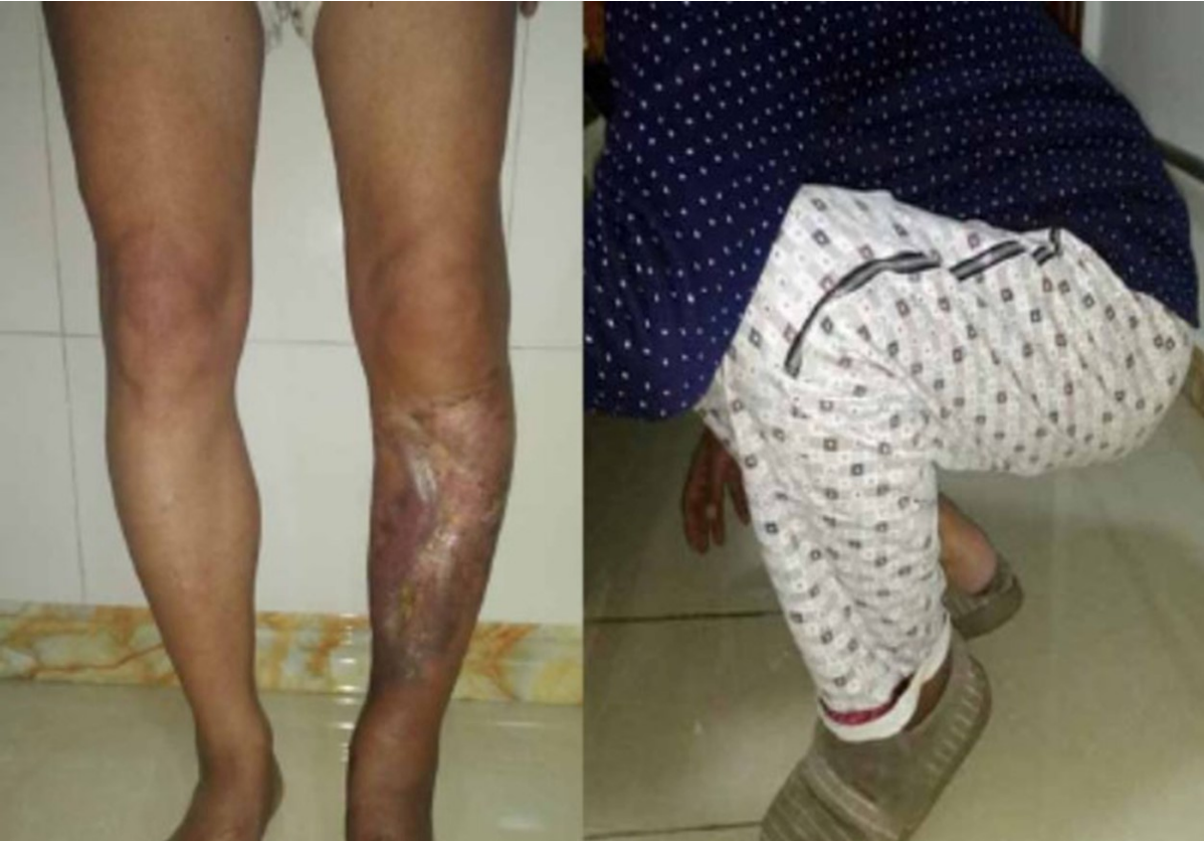
Figure 5. Postoperative recovery of